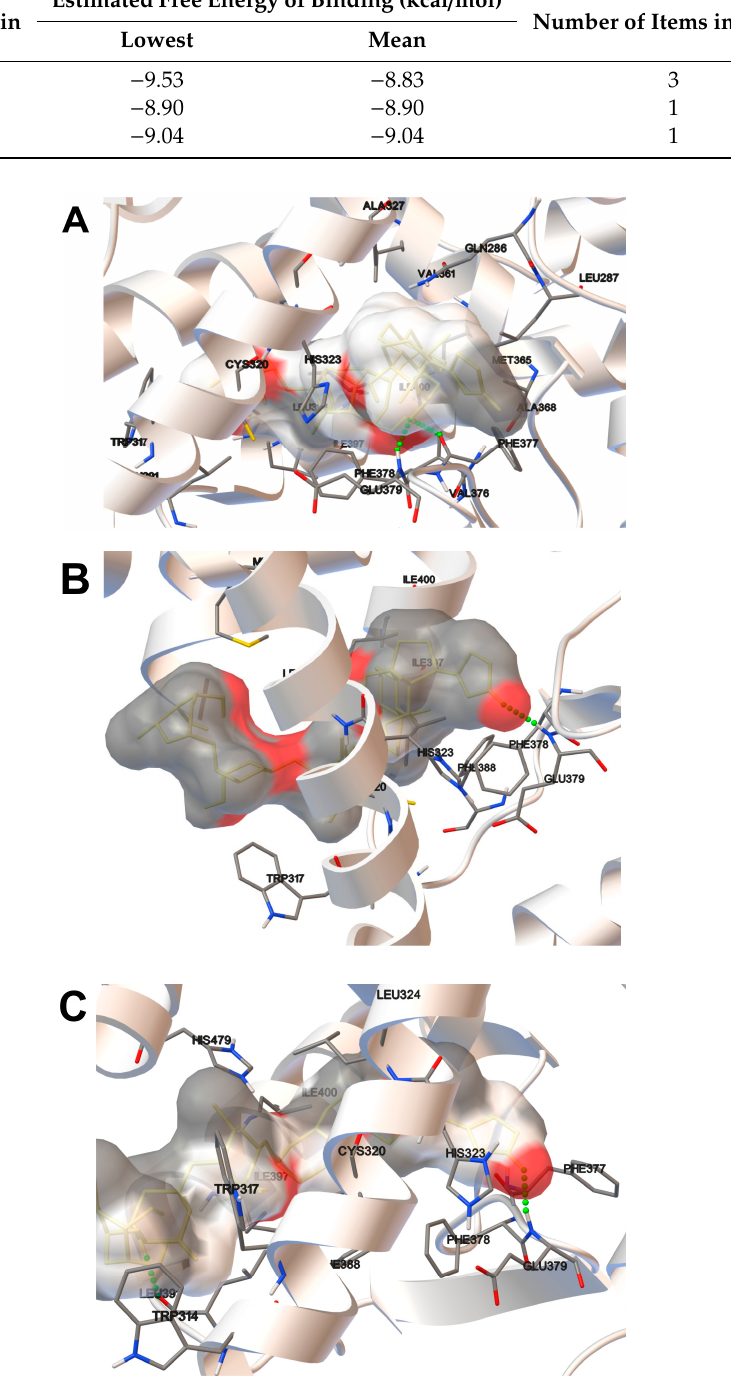
Figure 5. Molecular docking analysis of AZ5104 binding to the LBD (ligand binding domain) of ROR γ : 3L0J ( A ), 3B0W A ( B ), and 3B0W B ( C ). Hydrogen bonds are shown as green dots.